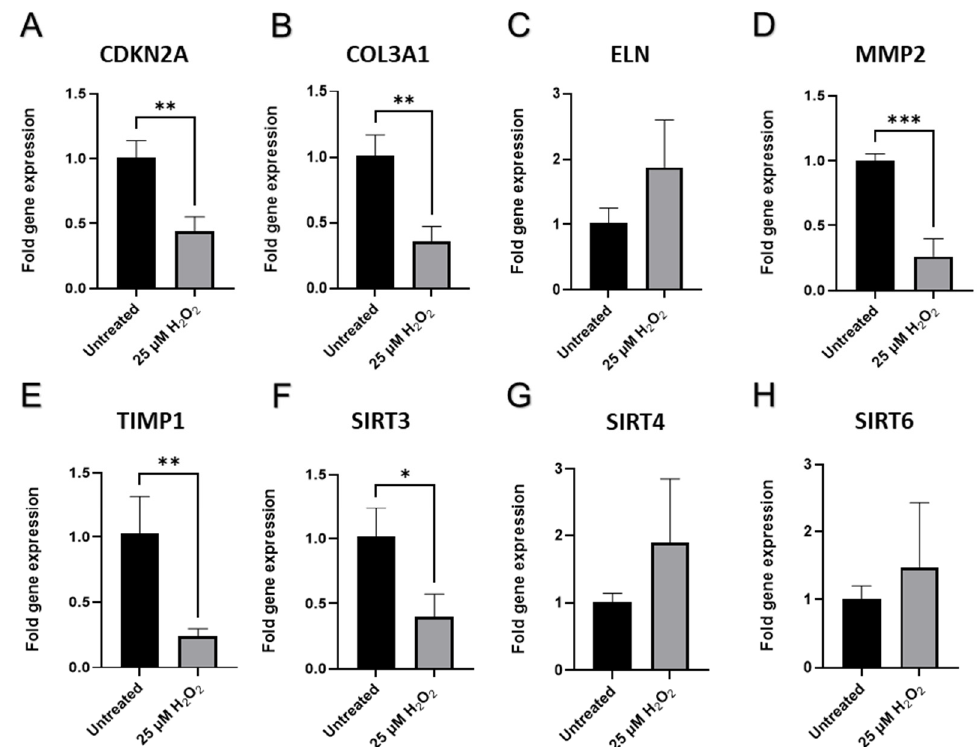
Figure 9. Senescence-associated gene expression in CCD-1064Sk (p.11) dermal fibroblasts (one-step senescence model). Changes in mRNA expression levels for selected genes measured by RT-qPCR in CCD-1064Sk cells: ( A ) CDKN2A ; ( B ) COL3A1 ; ( C ) ELN ; ( D ) MMP2 ; ( E ) TIMP1 ; ( F ) SIRT3 ; ( G ) SIRT4 ; ( H ) SIRT6 . Data were analyzed with an unpaired Student’s t -test. Significance is indicated within the figures using the following scale: ns, *, p < 0.05; **, p < 0.01; ***, p < 0.001. Bars represent mean ± SD.